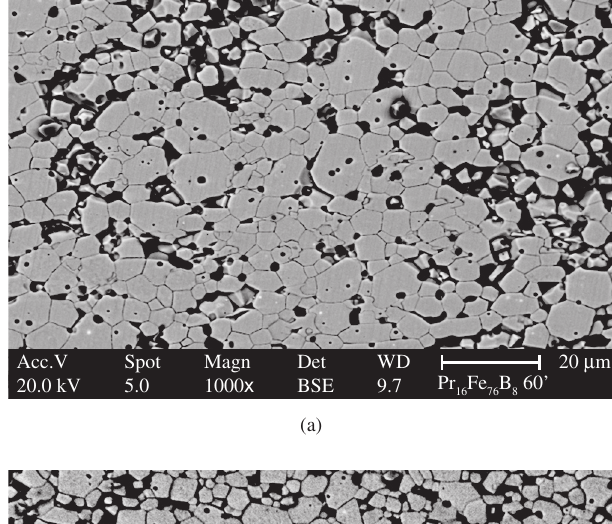
Figure 7. Exponential profile of the grain size reduction for the Pr magnets produced from the decrepitated ingot milled at 200